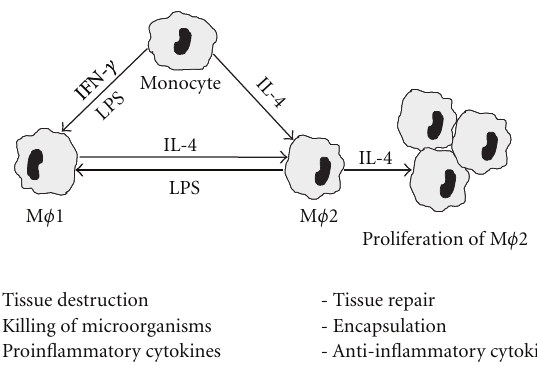
Figure 1: Simplified model of the paradigm of polarized macrophage activation. Monocytes are either classically (M φ 1) or alternatively (M φ 2) activated. Substances such as IFN- γ and LPS induce classical activation while IL-4, IL-13, and TGF β cause alter- native activation. M φ 1 macrophages typically produce high levels of proinflammatory proteins including TNF α , IL-1 β , IL-12, and IL-23 as well as reactive oxygen and nitrogen intermediates. M φ 2 produce high levels of the anti-inflammatory cytokines IL-10 and IL-1ra and show a high expression of scavenger and mannose receptors. Under the influence of IL-4, M φ 2 can accumulate in tissues by local proliferation rather than by recruitment. Either functional phenotype can shift to another depending on microenvironmental influences, speaking against rigid interpretation of the dichotomy between the macrophage